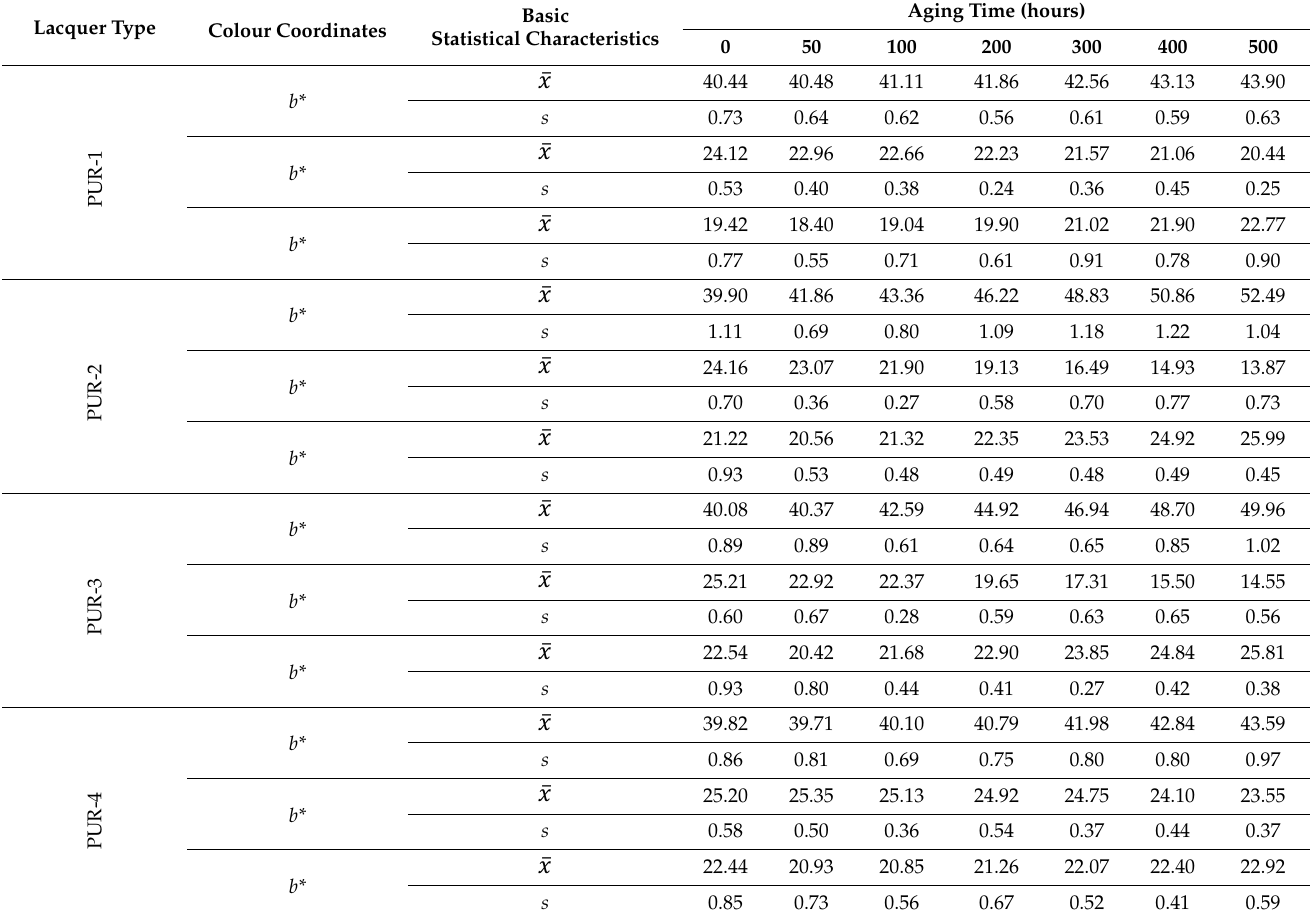
Table 3. Basic statistical characteristics of colour coordinates L * , a * , and b * corresponding to different phases of the accelerated aging process of spruce wood surface-treated with polyurethane lacquers. (The number of measurements for each set n = 50.)